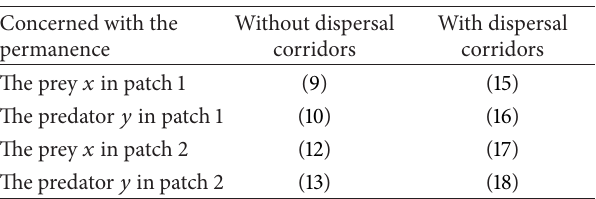
Table 1: Sufficient conditions for the permanence of models with- out/with dispersal